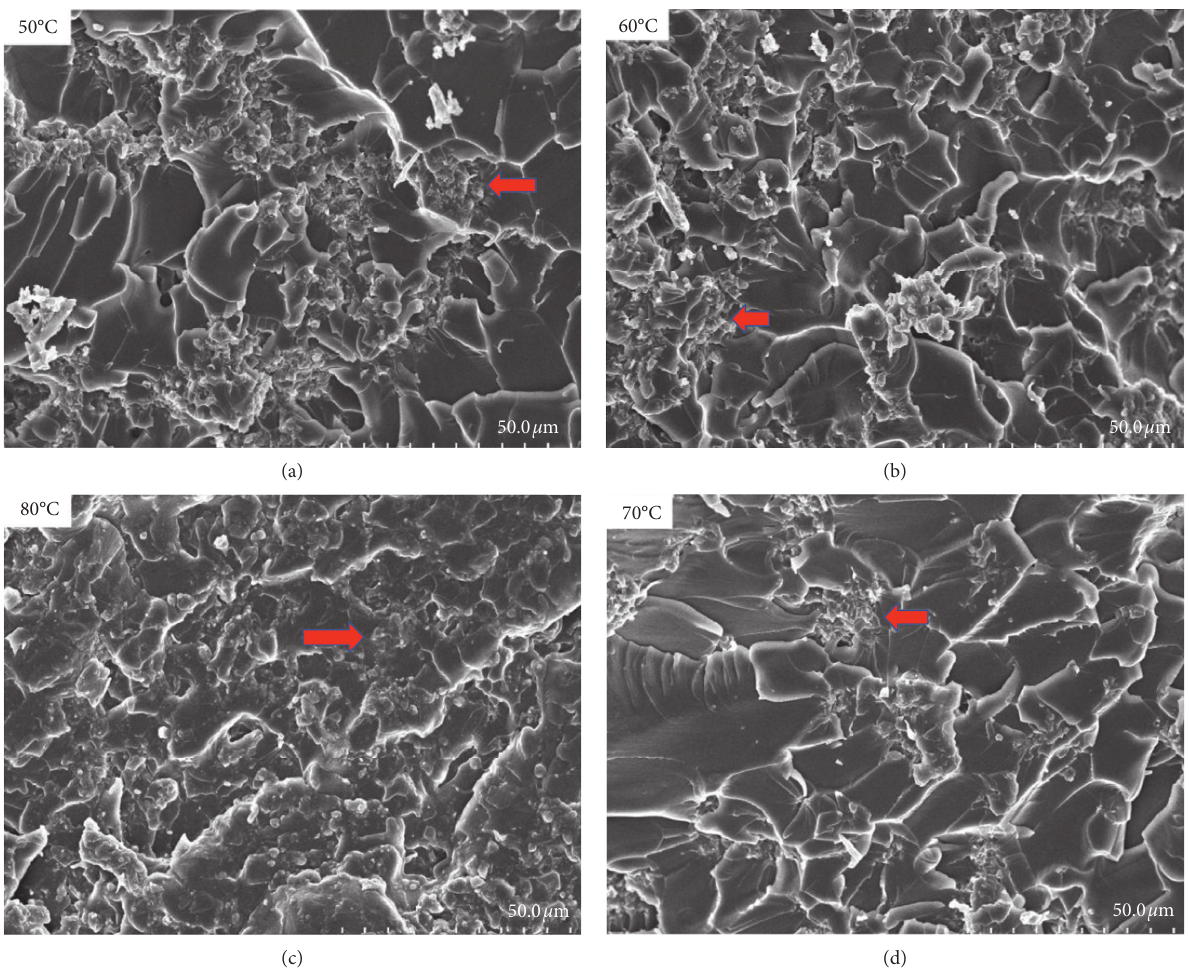
Figure 4: FE-SEM image of broken surface of epoxy Epikote 240 nanocomposite materials mechanically stirred at different temperatures: 50 ° C, 60 ° C, 70 ° C, and 80 ° C.